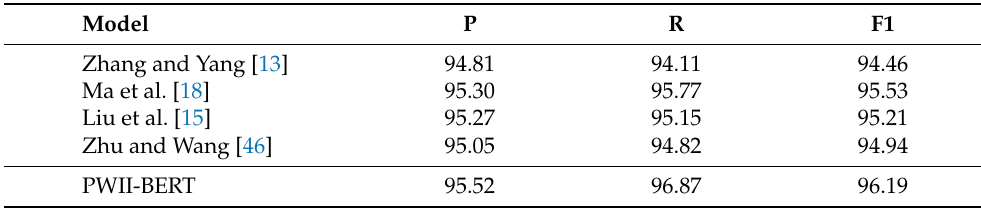
Table 2. Results of P, R, and F1 score on Resume